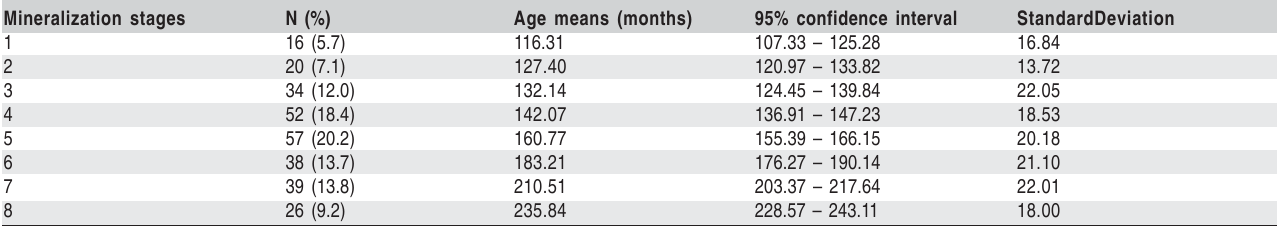
*Data from 282 subjects. Table 2. Tooth mineralization chronology of lower third molars*.